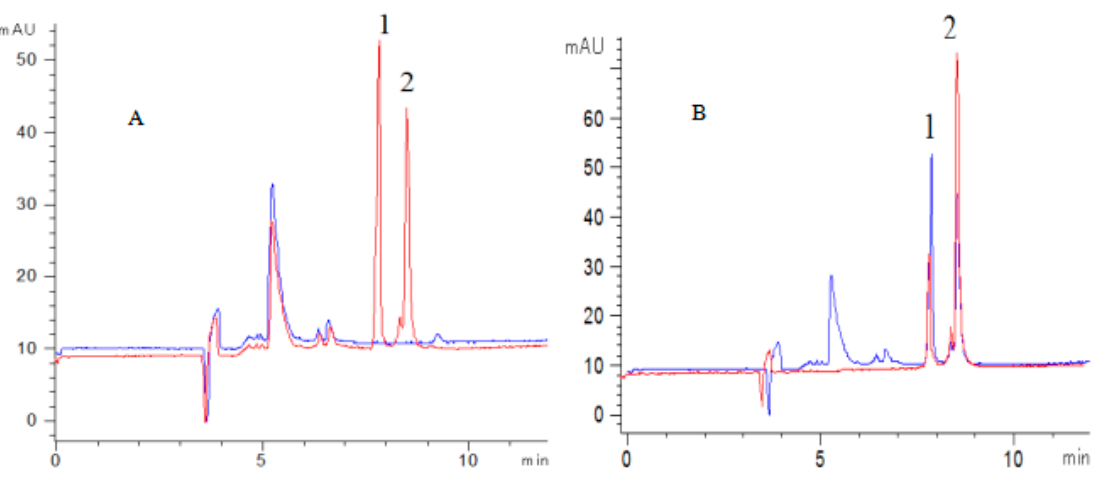
Figure 3. The typical electrophoretogram ( A ) The electrophoretogram of online mixing sample extract with (red) or without (blue) ferrous sulfate and ferrozine ( n = 3). ( B ) The electrophoretogram of online mixing ferrous sulfate, ferrozine with (blue) or without (red) sample extract ( n = 3). (1 Rutin, 2 Kaempferol-3-rutinoside, 3 Narcissoside, 4 Ferrozine, 5 [Fe(ferrozine) 3 ] 2 + , 6 Quercetin).